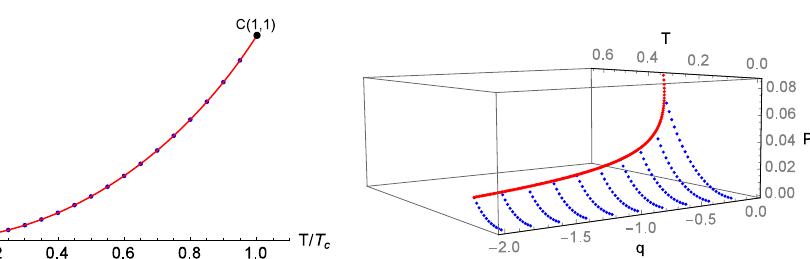
intheparameter q space. Eachbluedottedcurve indicatesaco-existence curve at a fixed q and the red curve at the boundary corresponds to the critical points